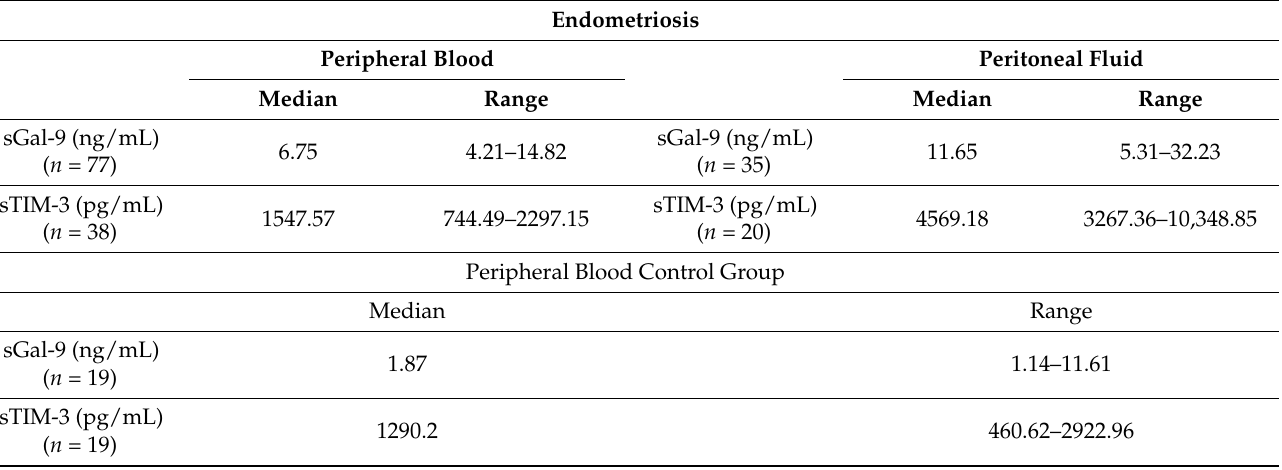
Table 2. Levels of sGal-9 (ng/mL) and sTIM-3 (pg/mL) in the plasma and PF of EMS patients and in the plasma of healthy